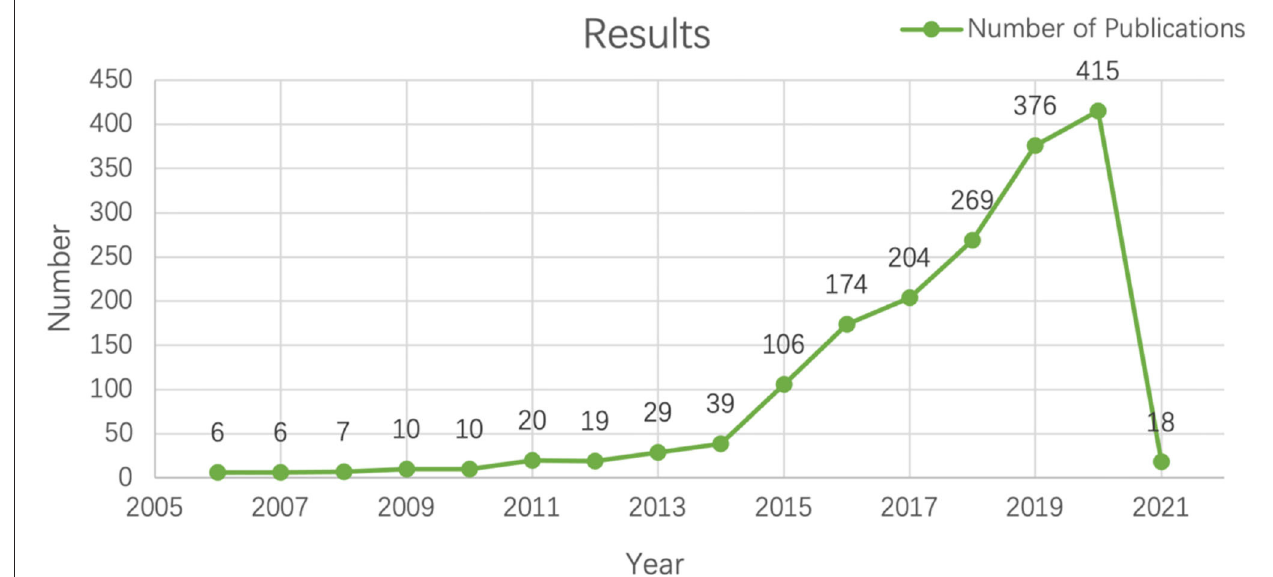
FIGURE 2 | The annual trends of publications of big data in education based on WoS core data